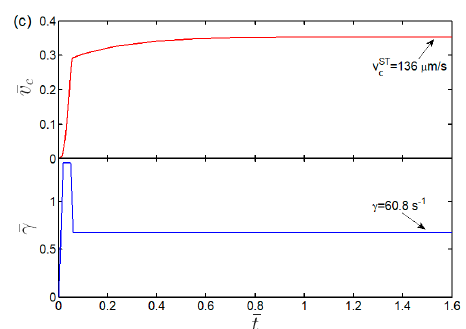
Figure A1. Dependence of steady speed of cell, v ST c , on the shear rate loading history of flow. In the three types of loading cases above, the final steady shear rates of flow are the same and equal to 60.8 s − 1 . However, the corresponding steady speeds of cell are ( a ) 1.82, ( b ) 67.8, and ( c ) 136 µm/s. Reference